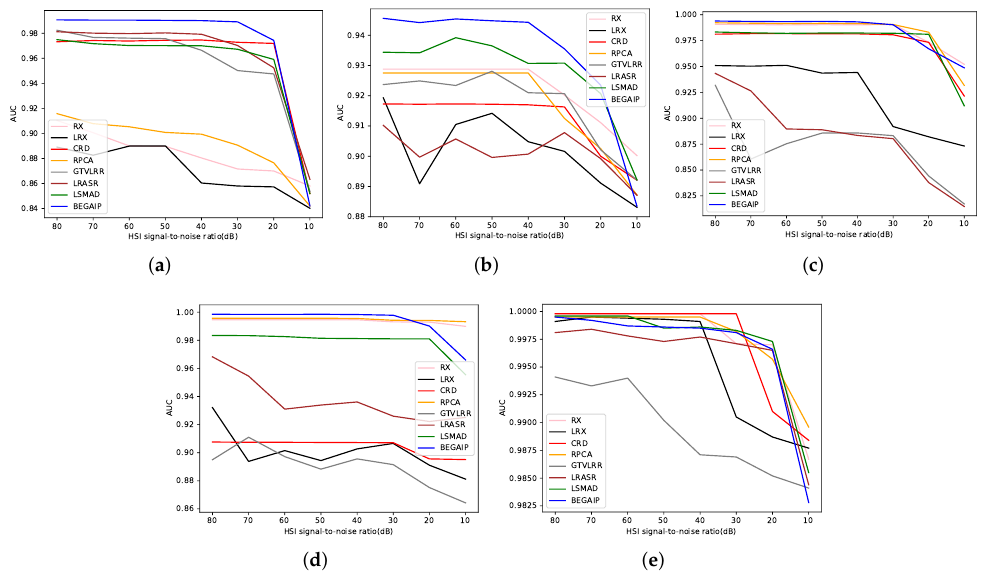
Figure 14. ROC curves of all the algorithms on four synthetic data sets. ( a ) San Diego data set. ( b ) Los Angeles data set. ( c ) TC data set-I. ( d ) TC data set-II. ( e ) Bay Champagne data